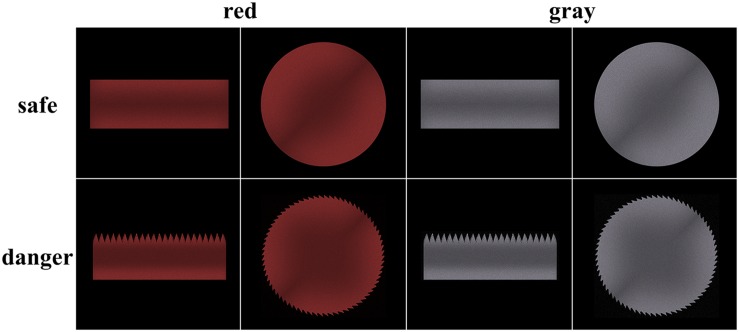
Schematic representation of the target stimuli.